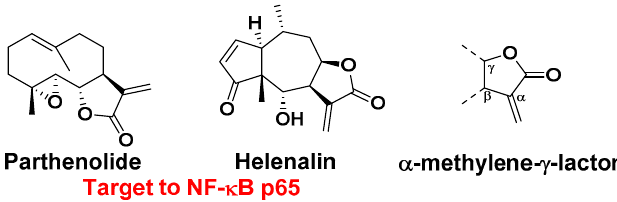
Figure 1. Chemical structure of representative anti-inflammatory sesquiterpene lactones (STLs) and relevant active moieties.